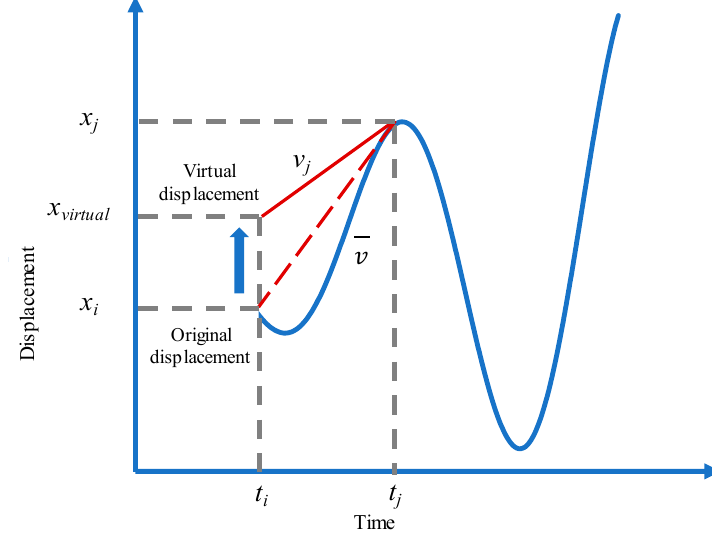
Figure 5. Virtual displacement vector and velocity mapping method.